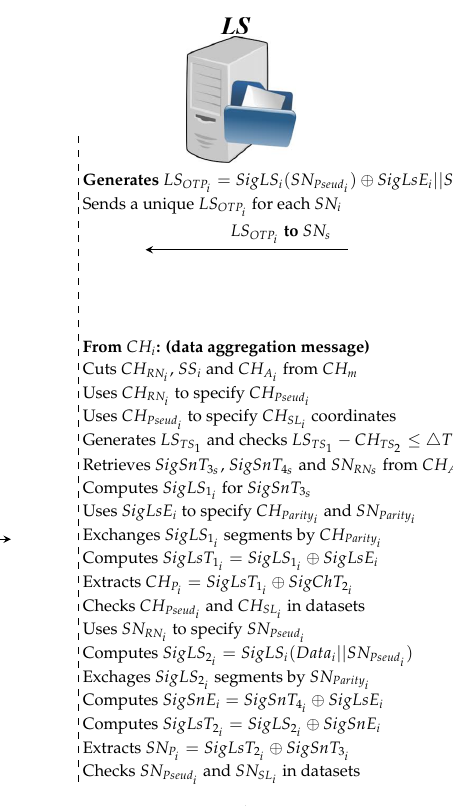
Figure 7. Data aggregation